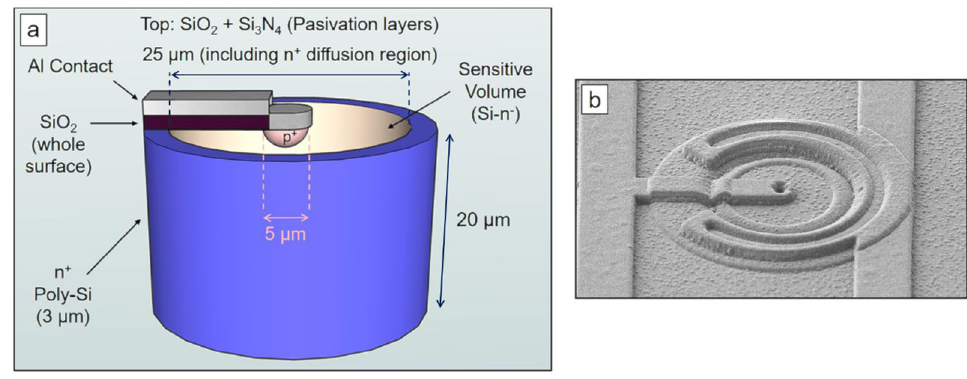
Figure 1. ( a ) Sketch of a 3D cylindrical microdetector (unitcell). ( b ) SEM image of the top surface of a